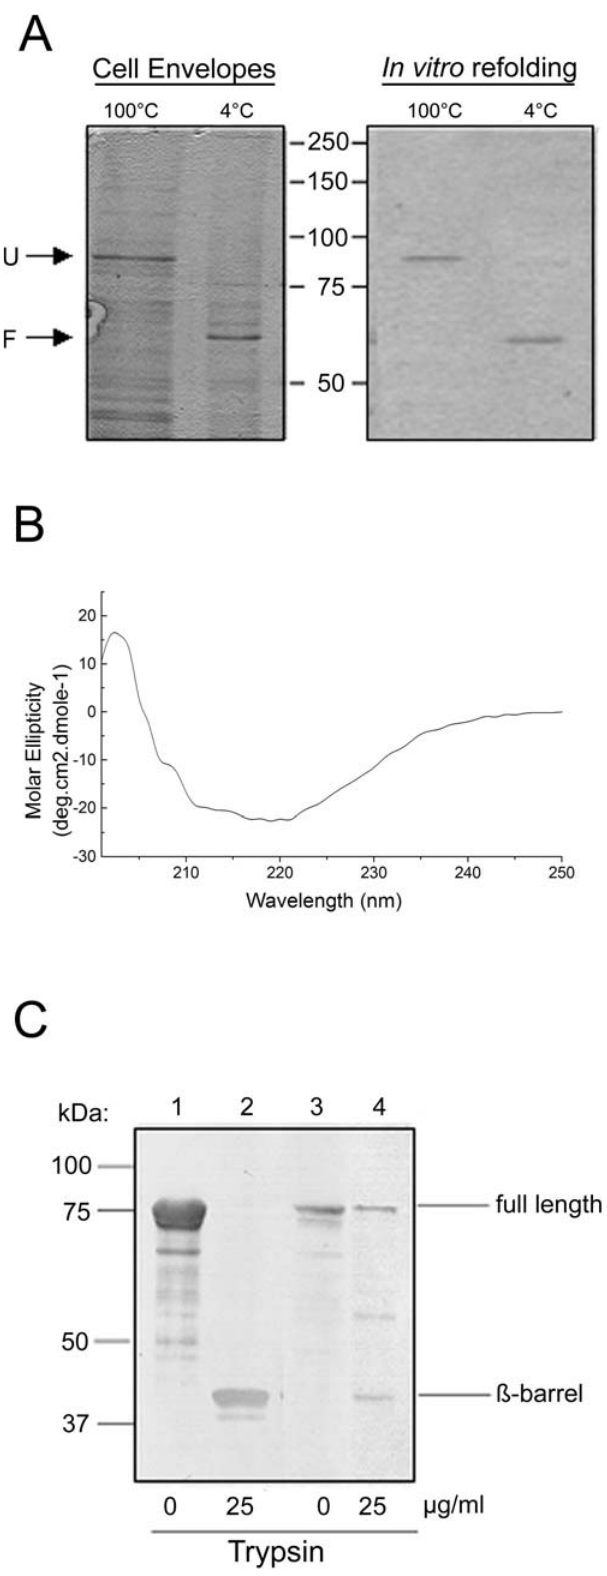
Figure 1. E. coli Omp85 Exhibits a b -Barrel Structure (A) Comparison of the heat modifiability of in vitro folded Omp85 (right panel) and Omp85 from cell envelopes of E. coli strain AM1095 pCLyaeT (left panel) in SDS-PAGE. Samples were either heated to 100 8 C or not before loading on the gel as indicated above the lanes. Only the